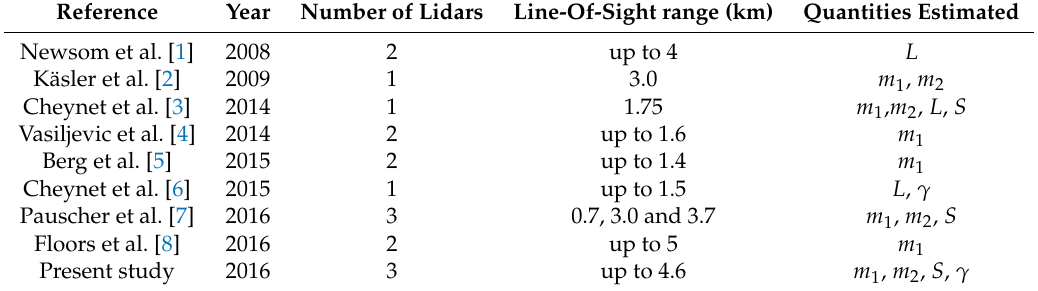
Table 1. Previous field measurements conducted using scanning pulsed lidar(s) to measure wind statistics in the surface layer at scanning distances larger than 1km, such as the mean wind velocity m 1 , the velocity standard deviation m 2 , the turbulence length scales L , the wind velocity spectrum S and/or the coherence γ